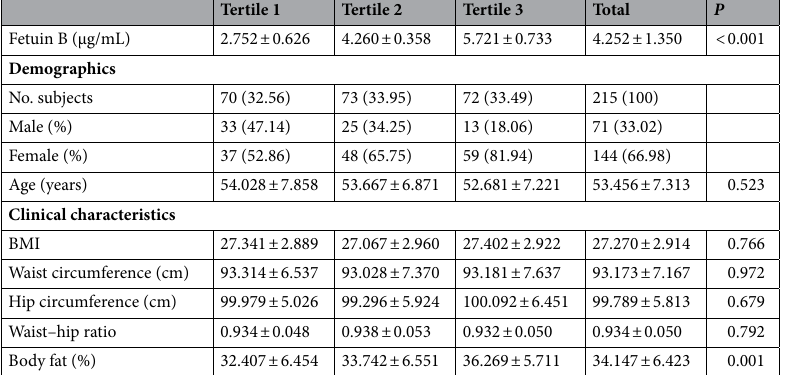
Table 1. Demographic and clinical characteristics of subjects according to the tertiles of serum Fetuin B. Data are given as the mean ± SD or as n (%). BMI body mass